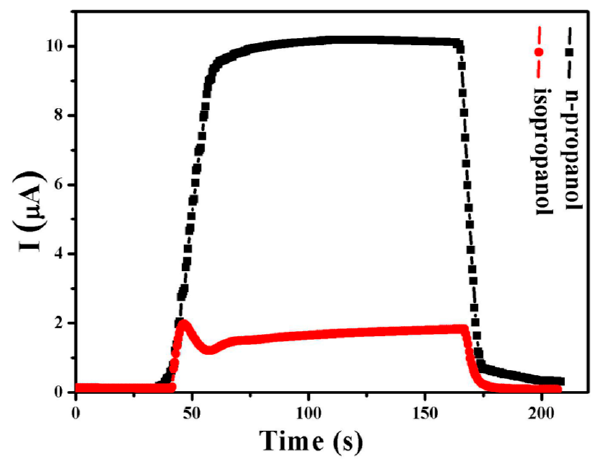
ppm isopropanol at 300 °C.